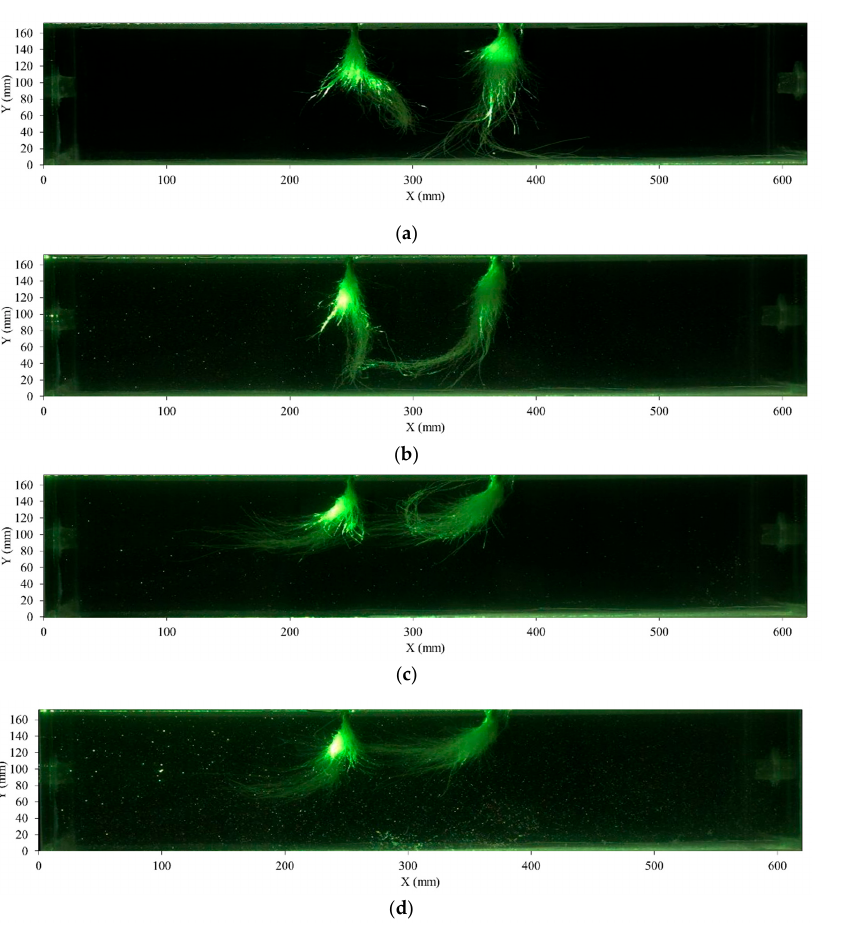
Figure 5. Plant roots under different flow rates. ( a ) 0 L/min; ( b ) 2 L/min; ( c ) 4 L/min; ( d ) 6 L/min; ( e ) 8 L/min.